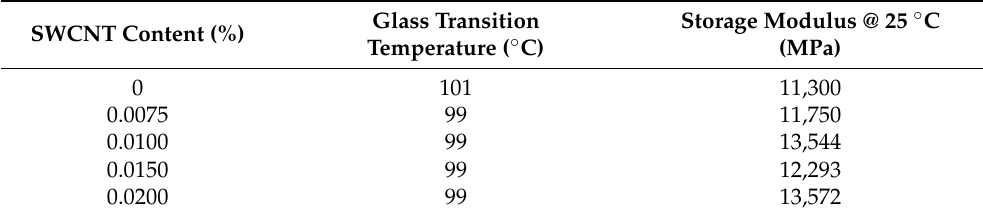
Figure 8. Dynamic Mechanical Analysis results of CFRP, tan delta (tan δ ). Table 2. S torage modulus ( E’ ) at room temperature and glass transition temperature (T g ) of CFRP determined from the tan delta.